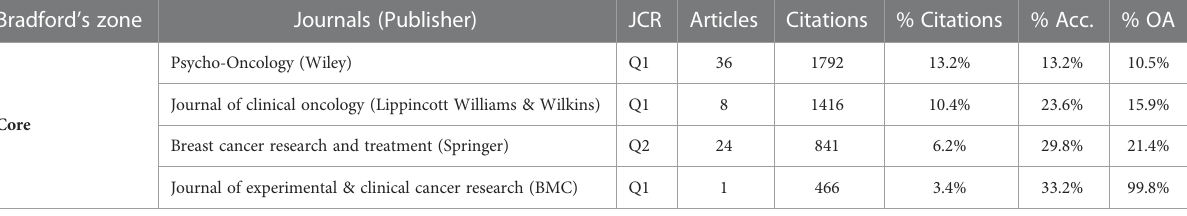
TABLE 1 Bradford core for journals on physical activity and breast cancer according to the number of citations of articles published in the journals. Bradford ’ s